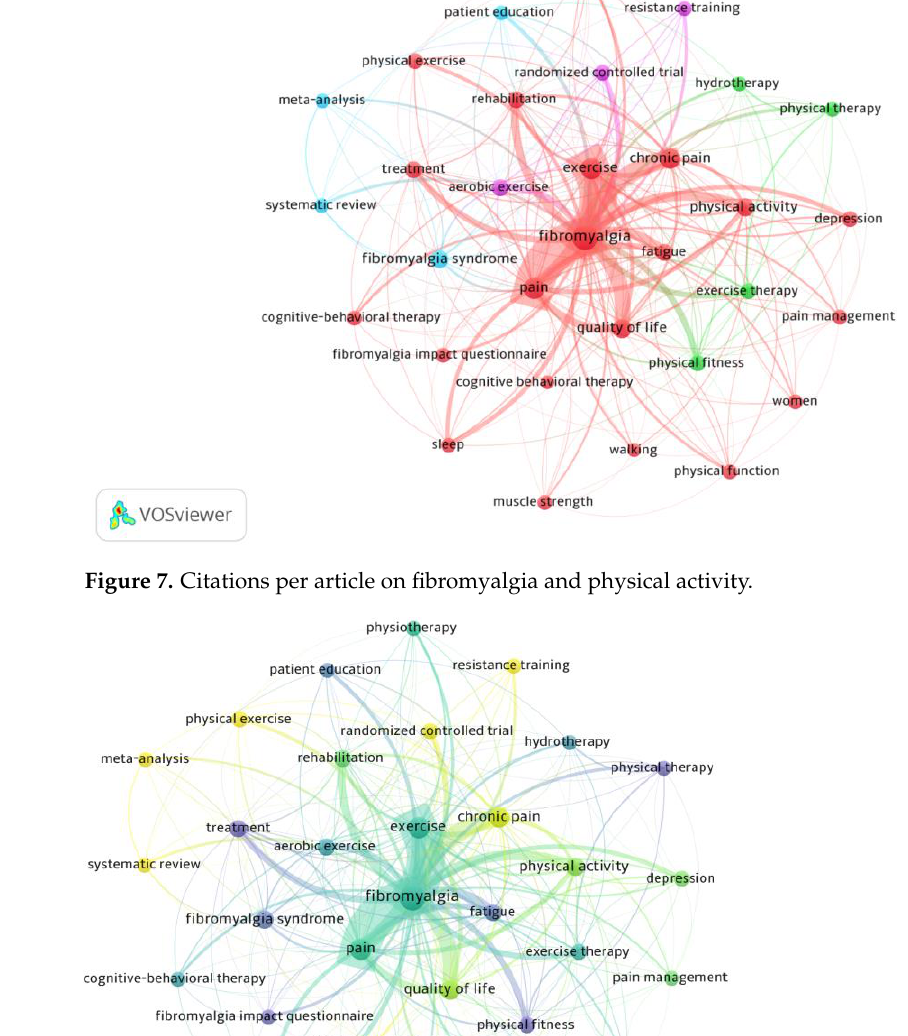
9 of 16 Figure 6. Citations per article on Fibromyalgia and Physical Activity. 3.7. Author Keywords After applying Zipf ’ s law, 32 keywords with 9 or more occurrences were highlighted. Four clusters were identified within the most frequently used keywords (Figure 7; analy- sis: association strength; attraction: 4; repulsion: − 2). The cluster with the most keywords had FM, their symptomatology and affected dimensions (pain, fatigue, chronic pain, de-